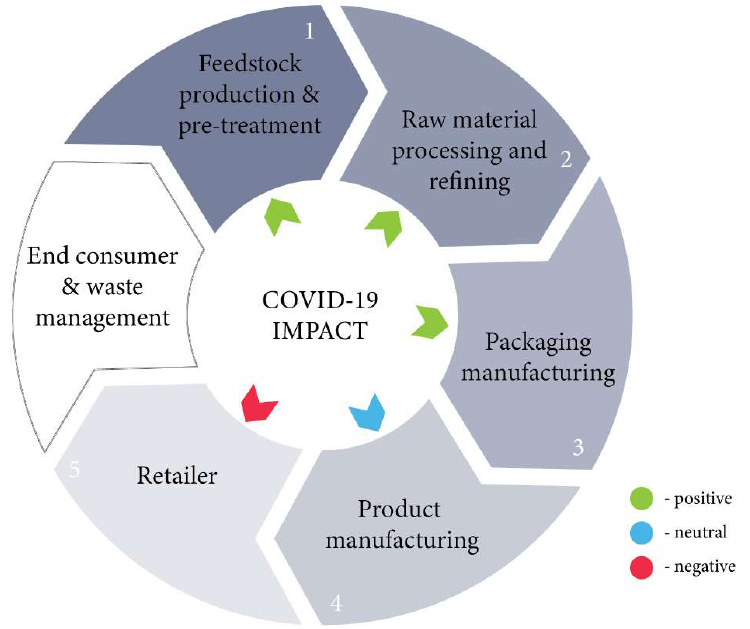
Figure 7. Conceptual model estimating the impact of the COVID-19 pandemic on the use of biocom- posite materials within each stage of the value chain (source: the authors).